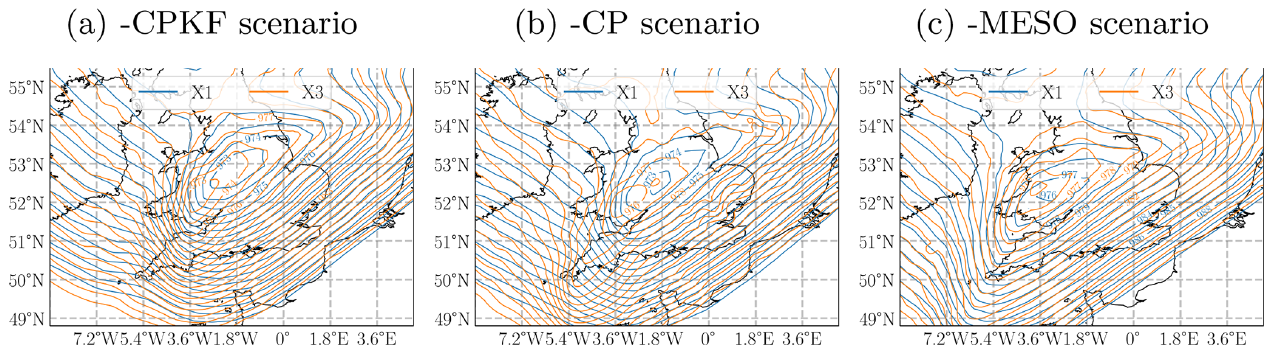
Figure 7. Contours of sea level pressure (in hPa) of variable-resolution (X3) and quasi-uniform (X1) MPAS configurations for a given set of model physics at 28 October 2013, 06:00 UTC: (a) the -CPKF, (b) -CP and (c) -MESO physics configuration. Contours are drawn from 973 to 990hPa with 1hPa intervals. Naming of the MPAS configurations follows Table 3.